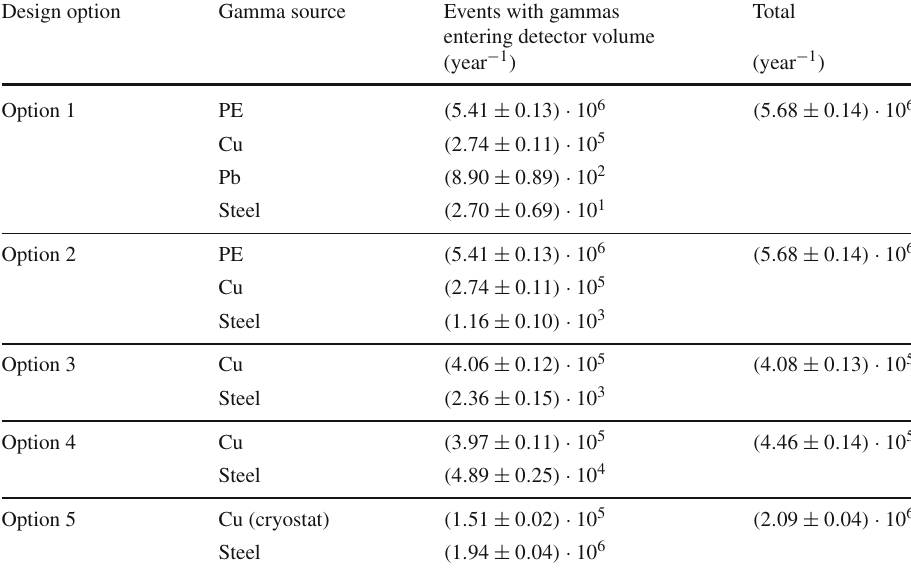
Table 5 List of all the background contributions in every shielding option considered in the Geant4 simulations. The numbers are attained using the simplified geometrical setup detailed in Sect. 3 and represent